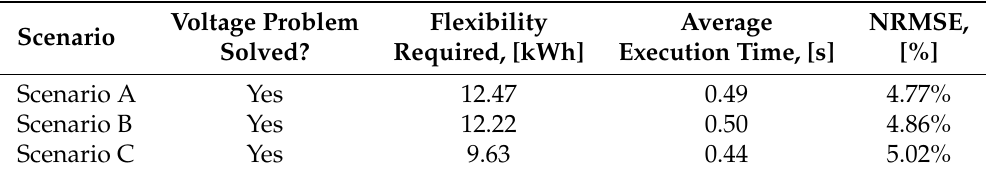
Table 8. Forecasting functions evaluation